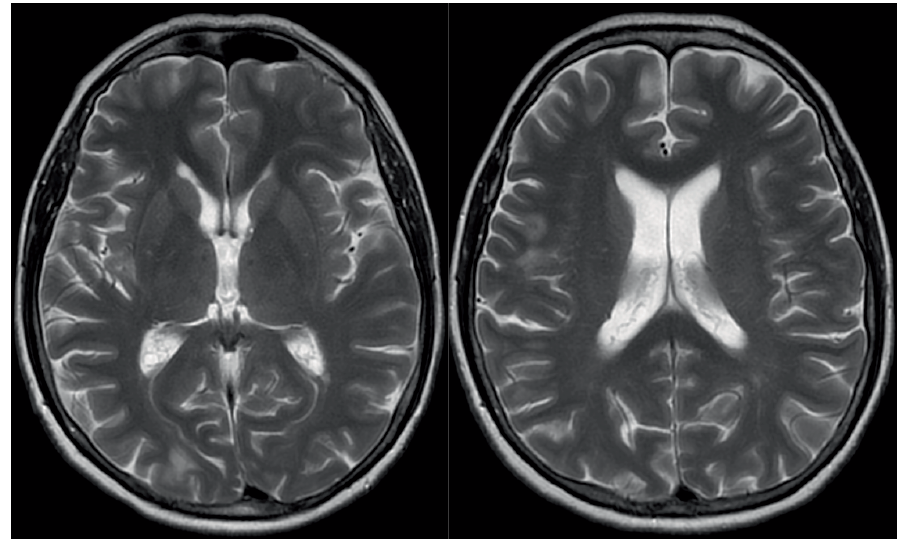
2: Transversal T2-weighted MR images one year after endovascular treatment revealed only subtle remaining signal